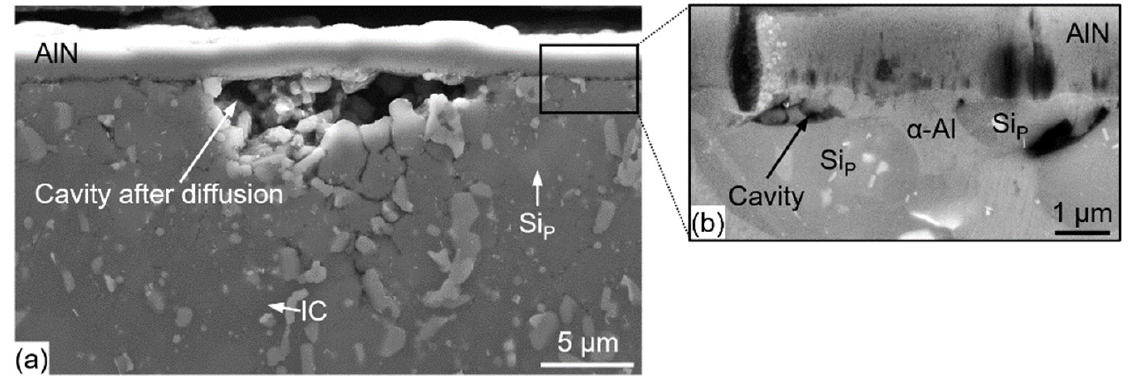
Figure 1. Initial state after plasma nitriding (formation of a thin AlN layer) of a hypereutectic spray- compacted Al alloy with primary silicon Si P and different intermetallic compounds IC: ( a ) SEM overview image; ( b ) detail from the interface.